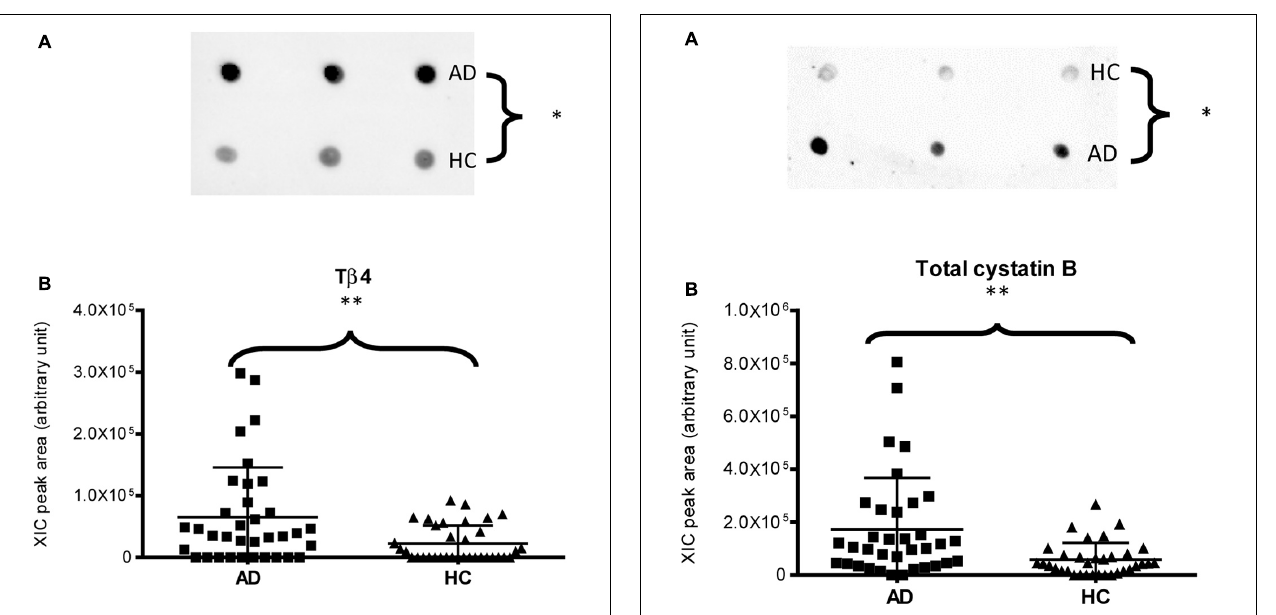
FIGURE 4 | Dot-blotting immunodetection of total cystatin B in salivary pools of AD and HC samples (A) and distribution plot of the XIC peak area values of total cystatin B measured by HPLC-ESI-MS (B) in each salivary sample from the AD and HC groups (XIC peak areas of the three identified proteoforms of cystatin B were considered in the sum, see Supplementary Table 2 ) ( ∗ , p < 0.05; ∗∗ , p <